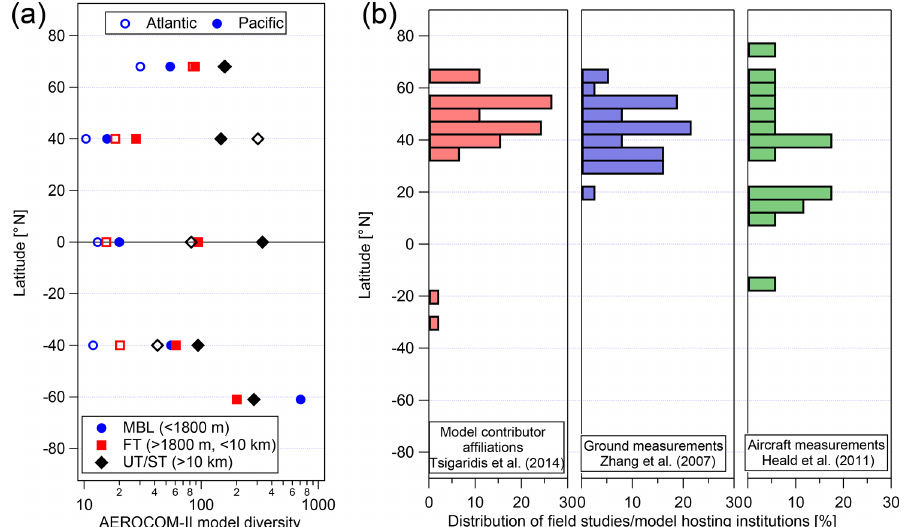
Figure 1. (a) The ratio between the average OA concentrations of the highest and the lowest models (for each region) as predicted among 28 global chemistry transport models participating in the AeroCom Phase II intercomparison study (Tsigaridis et al., 2014). (b) Geographical distribution of institutions at which the AeroCom-II models were run and/or developed (based on author affiliations) and of the field mea- surements included in two major literature overview studies (Zhang et al., 2007; Heald et al., 2011) for the OA ground and aircraft AMS as a function of latitude. For the aircraft campaigns, the average latitude for the full deployment was